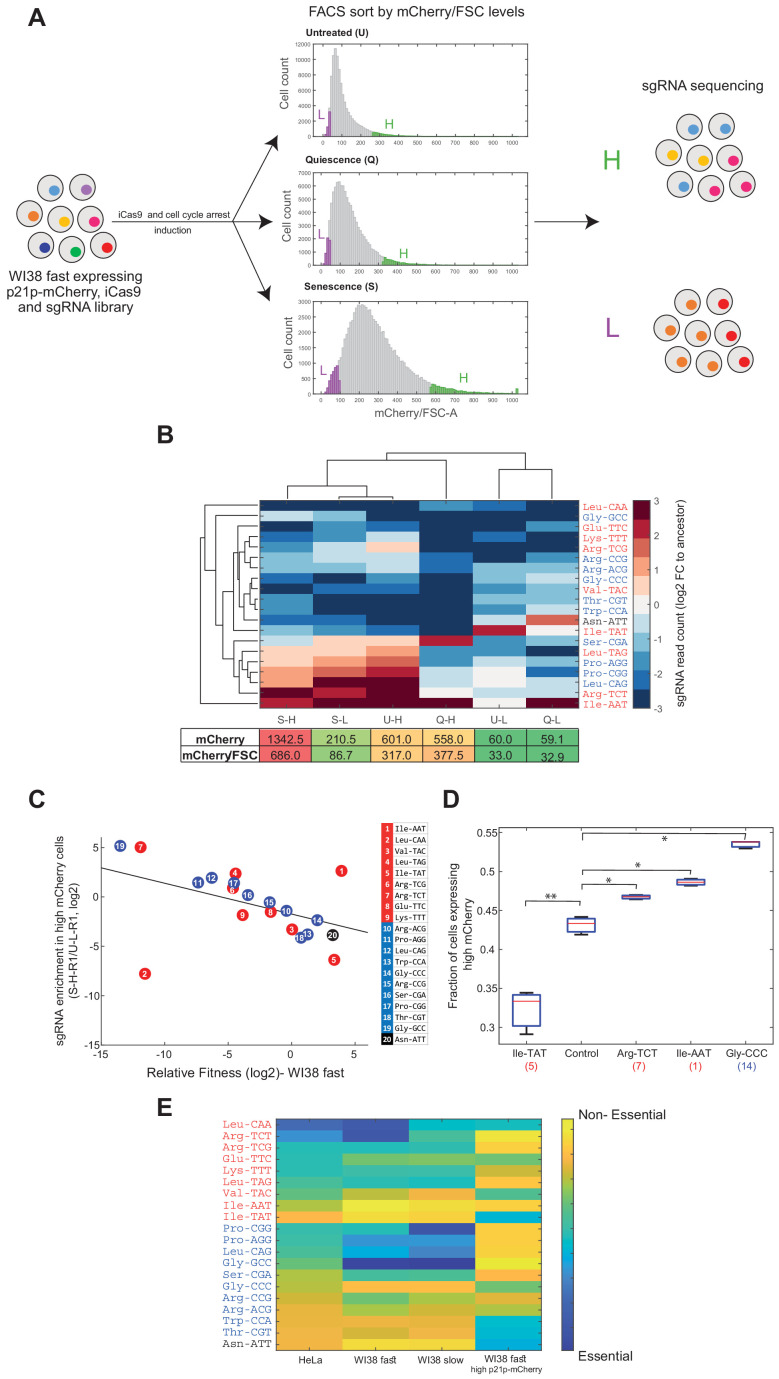
Essentiality of tRNAs for the response to cell cycle arresting signals.(A) A multiplexed assay for tRNA essentiality for growth arrest signals. The tRNA-sgRNA library was transduced into WI38 fast cells that express iCas9 under doxy inducible promoter and mCherry gene under the endogenous promoter of human p21. After the induction of iCas9, we split the cell population (ancestor sample) into three populations, each treated with different conditions to stimulate the entrance to a cell cycle arrest state. After 2 days, we measured the mCherry/FSC levels of each population using FACS. The distributions of the three populations, based on the mCherry/FSC are shown in the middle (U - untreated; Q - quiescence; S - senescence). Then, each population was sorted according to the mCherry/FSC ratio, while sampling the top and bottom 5% of each population (High bin-labeled in green; Low bin-labeled in purple). Then, we extracted the genomic DNA of each sample and deep sequenced the sgRNAs, looking for enriched and depleted sgRNAs (relative to the ancestor sample). (B) Hierarchical clustering of the sorted samples and the sgRNAs based on the averaged changes (two biological repeats) in the sgRNA read count of each sorted sample normalized to the ancestor sample (log2). The lower table depicts the mean mCherry level and the mean mCherry/FSC ratio of each sorted population, based on the FACS measurements. (C) A scatter plot comparing the essentiality of tRNAs to cellular proliferation and enterance into cell arrest in WI38 fast cells. (regression model, sgRNA abundancy in high p21-mCherry cells as a linear function of the relative fitness of tRNA-targeted WI38 fast cells, had a slope of −0.38 and intercept of −1.47; Pearson correlation, r = −0.45, p<0.05). Colors of tRNA families are as in previous Figures. (D) A box plot presenting the fraction of cells expressing high mCherry levels (>1700 relative fluorescence intensity (arbitrary units)) in each CRISPR-targeted tRNA variant (three biological repeats). The control sample is expressing a random sgRNA with no target sequence in the human genome. The number in parentheses on the x-axis denotes the number of the targeted tRNA family genes, as in subfigure C. A two-sample t-test was conducted to compare each sample to the control. * indicates p<0.05; ** indicates p<0.01. (E) A heat map summarizing the essentiality of each tRNA to different cell lines and proliferation states. Each row represents a tRNA family, classified to proliferation (red), differentiation (blue), or pseudo (black) tRNAs. Each column represents a cell line or condition. The color code depicts the essentiality of the tRNA. The essentiality is the (log2) fold-change in sgRNA read count in each experiment (as described in; Figure 4A Figure 4B; Figure 4C and subfigure C).